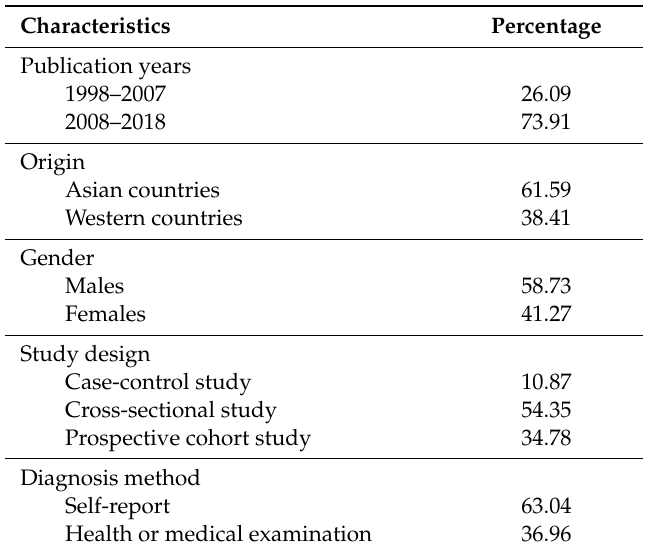
Table 1. Characteristics of the 46 papers